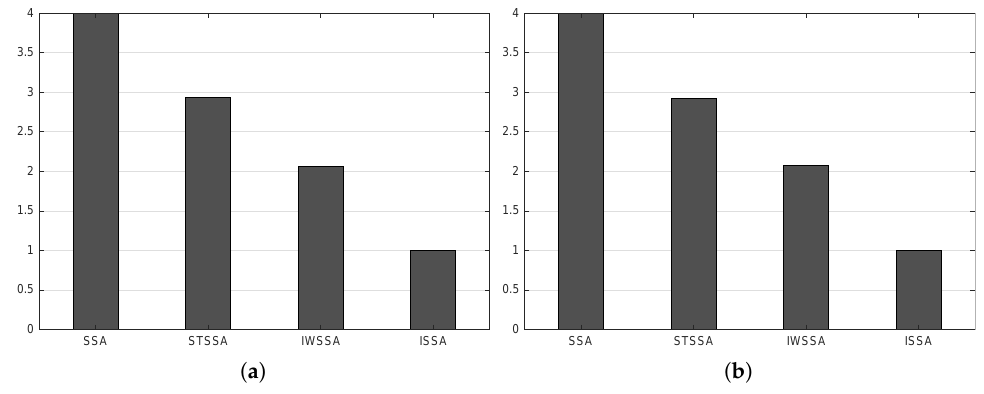
Figure 6. Average ranking of comparative algorithms by Friedman test ( a ) and Quade test ( b ).